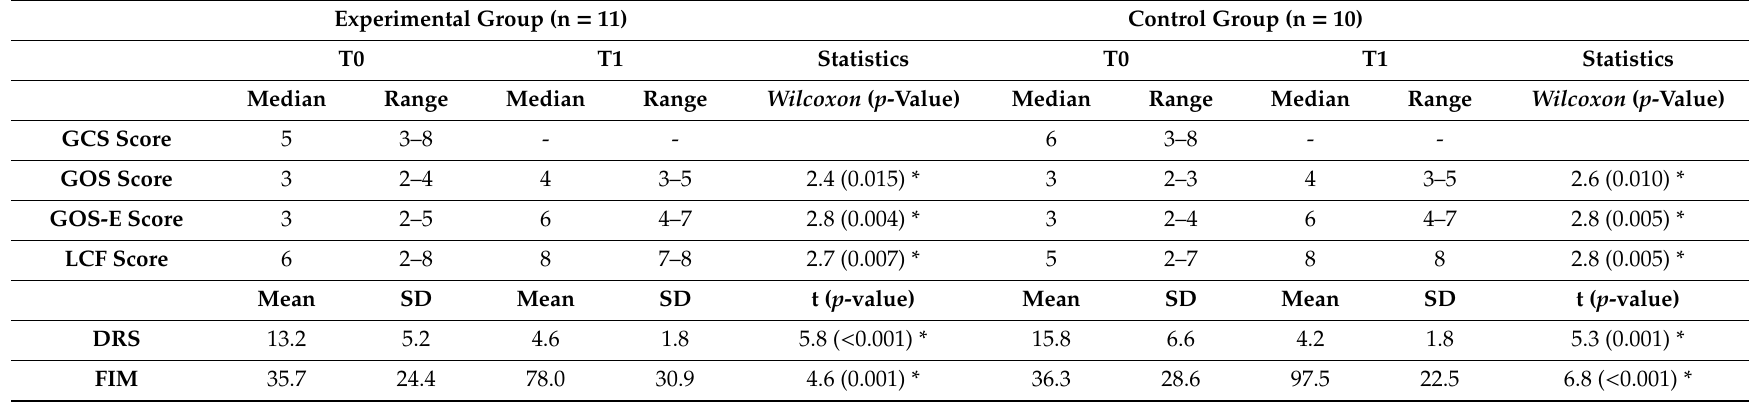
Table 2. Scores at the clinical and behavioral scales, before (T0) and after (T1) rehabilitation. Experimental and Control groups are reported in separate columns. Experimental Group (n = 11) Control Group (n = 10) T0 T1 Statistics T0 T1 Statistics Median Range Median Range Wilcoxon ( p -Value) Median Range Median Range Wilcoxon ( p -Value) GCS Score 5 3–8 - 6